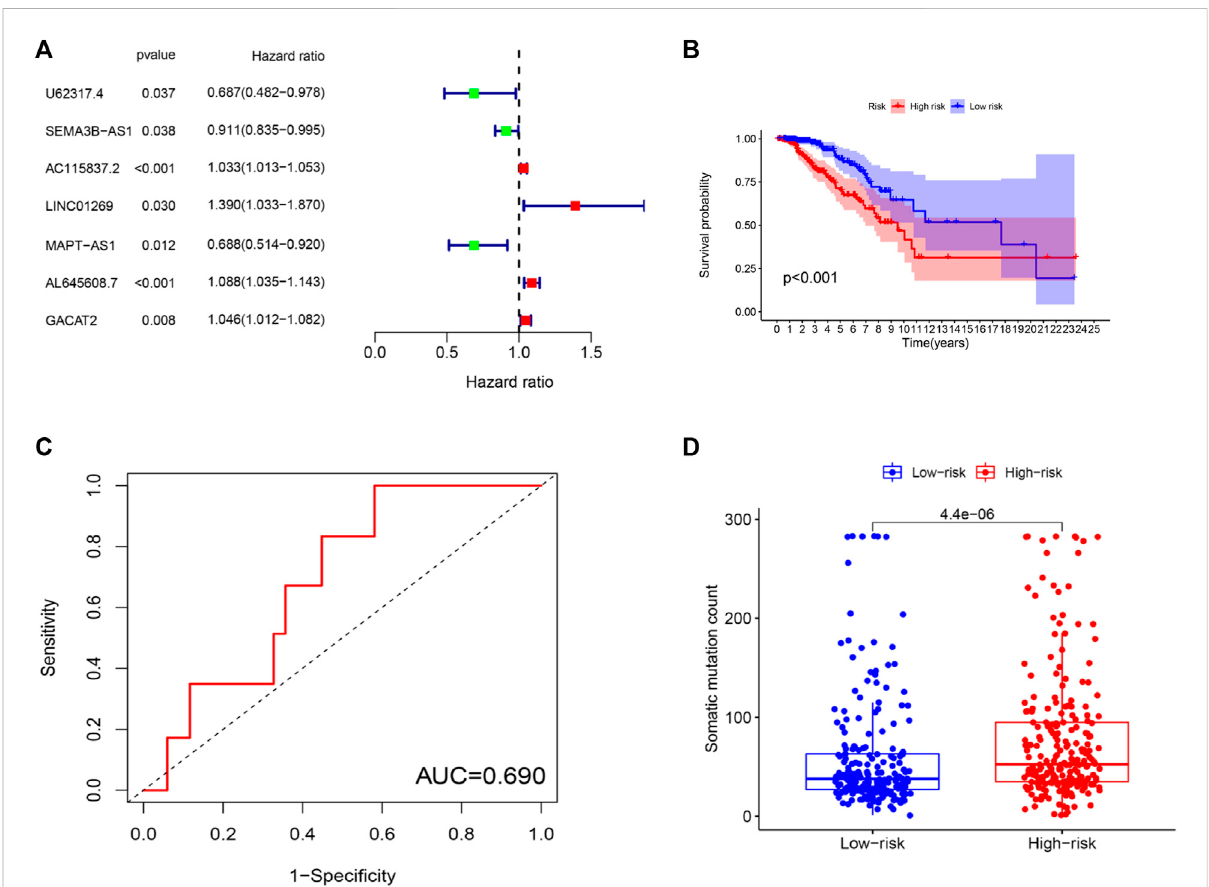
FIGURE 3 Establishment of genetic instability-related lncRNA signature (GILncRNASig) for prognosis prediction and identi fi cation of the predictive ef fi cacy of themodel. (A) . Forest plot of7 lncRNAs, which werescreened from candidate genetic instability-derivedlncRNAs throughunivariate Cox analysis and Lasso analysis. (B) . Kaplan – Meier curves of overall survival of patients with low or high risk predicted by the GILncRNASig in the training set. (C) . Time-dependent ROC curve analysis of the GILncRNASig. (D) . Boxplot of somatic mutations count between the High-Risk and Low- Risk groups in the training